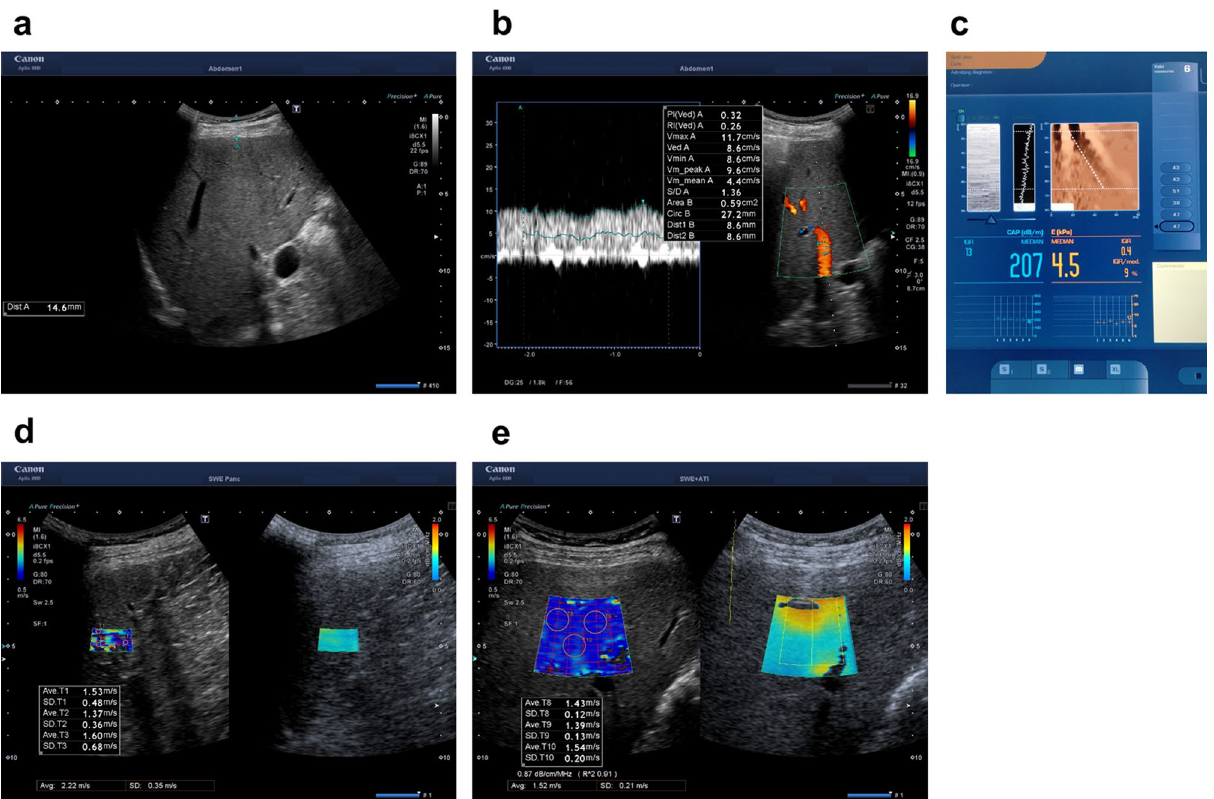
Figure 1. Methods used for liver evaluation. ( a ) B-mode image. ( b ) Transient elastography (TE) and controlled attenuation parameter (CAP) with FibroScan. Sample display showing the echo M-scan on the left, single-line amplitude A-scan in the middle, and the displacement M-mode after a vibration-controlled impulse push on the surface on the right. Numeric values for CAP are displayed on the left (db/m) and those for TE are displayed on the right (kPa). ( c ) Illustration of a 2D-SWE measurement and an attenuation image (ATI) acquisition of right liver lobe performed using Aplio i800. Elasticity map was displayed on the left and the level of attenuation was color-coded and displayed in the ROI on the right. Each numeric results expressed in kPa and in dB/cm/Mz are displayed on the bottom of the image. ( d ) Illustration of a 2D-SWE measurement of spleen performed using Aplio i800. ( e ) Illustration of the V max measurement of right portal vein.